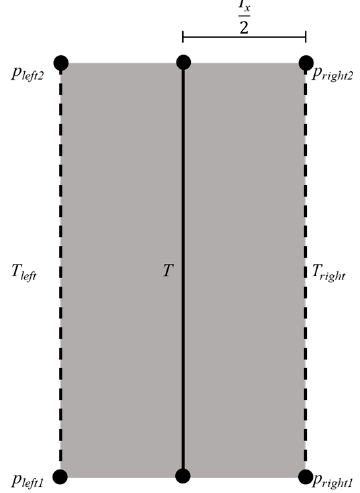
Figure 3. Area covered when the tractor crosses the T tillage line.